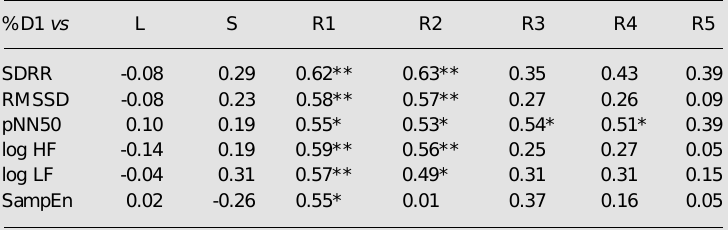
Table 2. Pearson’s correlation coefficients (r) of percent decrease of heart rate during the 1st min of post-exercise recovery (%D1) with heart rate variability and heart rate complexity indices obtained during various phases of the experiment.